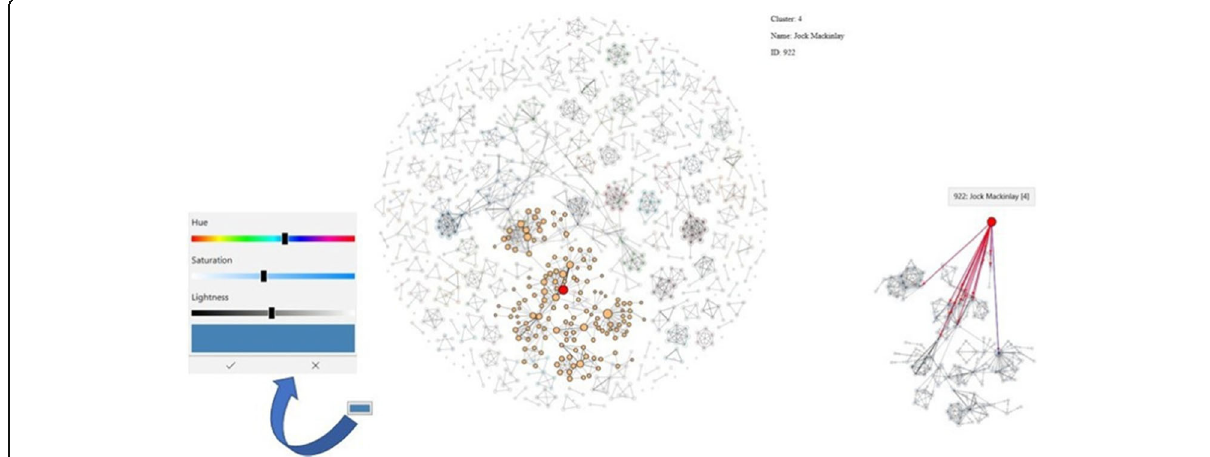
Fig. 11 Selecting a cluster of nodes to take a closer look at the details, e.g., a node that is important in this